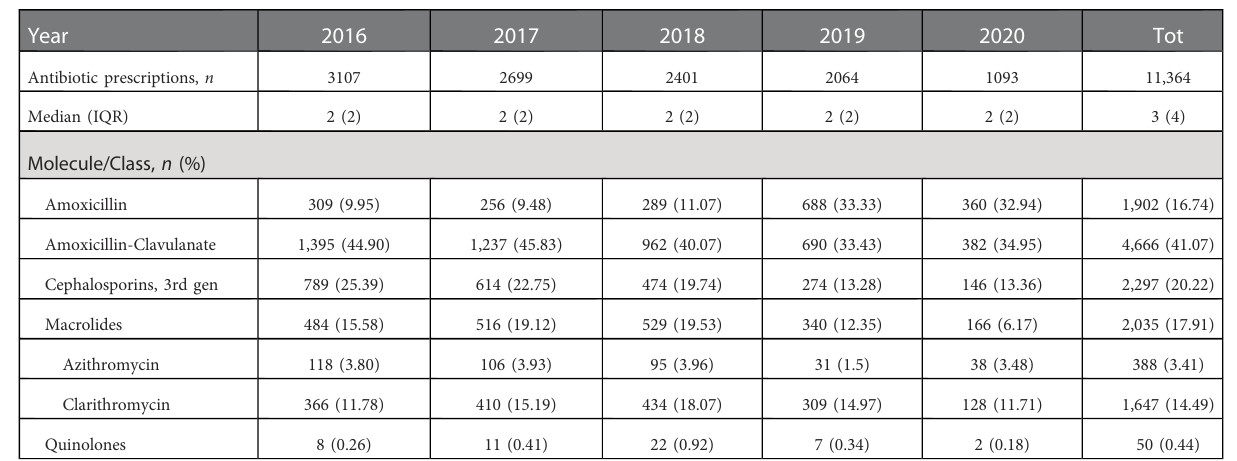
TABLE 3 Antibiotic prescriptions distribution and